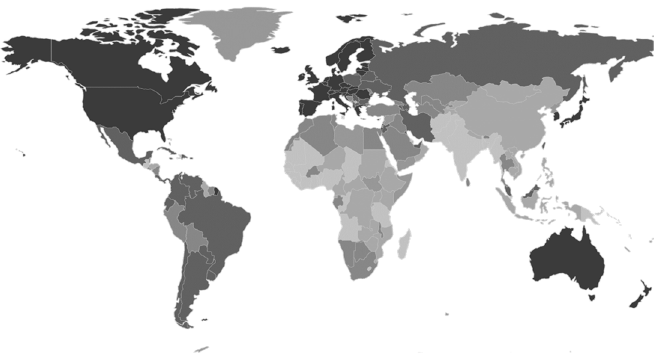
Figure 4. Environmental Performance Index—EPI. Source: Fortang (2021). Countries with darker colors have higher potential for climate resilience.